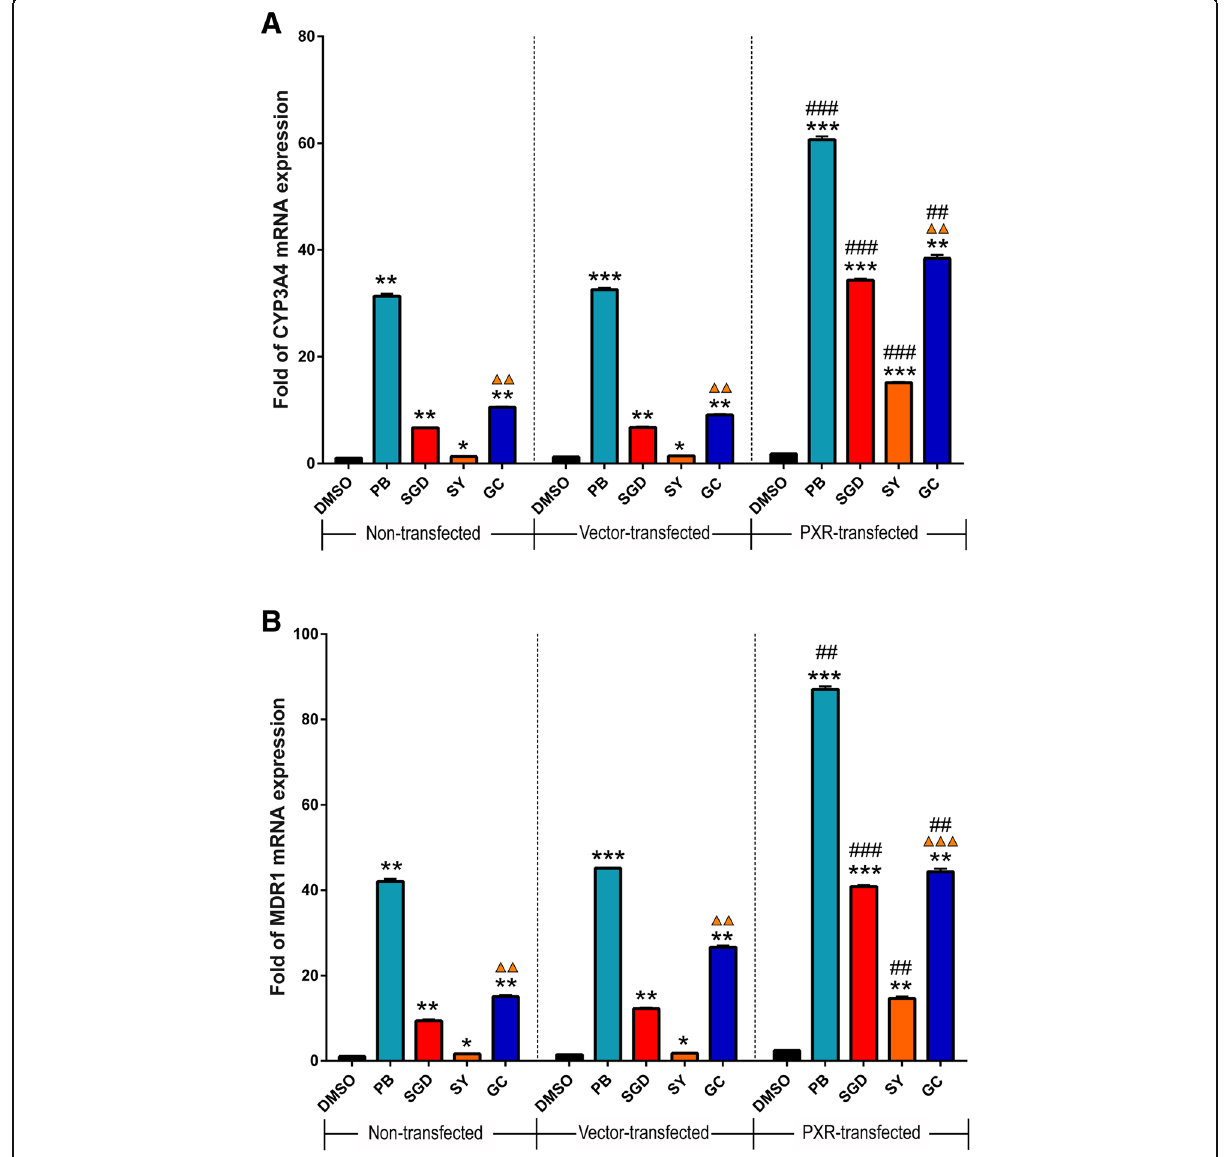
Fig. 5 The up-regulation of phenobarbital (PB), SGD, SY, GC on CYP3A4 ( a ) and MDR1 ( b ) mRNA expression. LS174T cells were transfected with 400 ng/well pcDNA3.1-PXR, or pcDNA3.1 vector, or weren ’ t transfected. Cells were then exposed to phenobarbital (1 mM), or SGD (1 mg/ml), or SY (1mg/ml), or GC (1mg/ml) for 48h. mRNA expression of CYP3A4 and MDR1 was determined using real-time qPCR. Data are presented as -fold increase to non-transfected group with DMSO treatment. Data are presented as means ± S.E.M of three independent experiments performed in triplicates. Statistical significance was determined by one-way ANOVA with Welch correction, followed by the Games Howell test. One-way ANOVA with Welch ’ s correction revealed significant differences among the groups (Welch ’ s p <0.001). * p <0.05, ** p <0.01, *** p <0.001 compared to the DMSO group with the same transfection; ▲▲ p <0.01, ▲▲▲ p <0.001 represents GC group compared to SY group with the same transfection; ## p <0.01, ### p <0.001 compared to vector-transfected group with the same drug